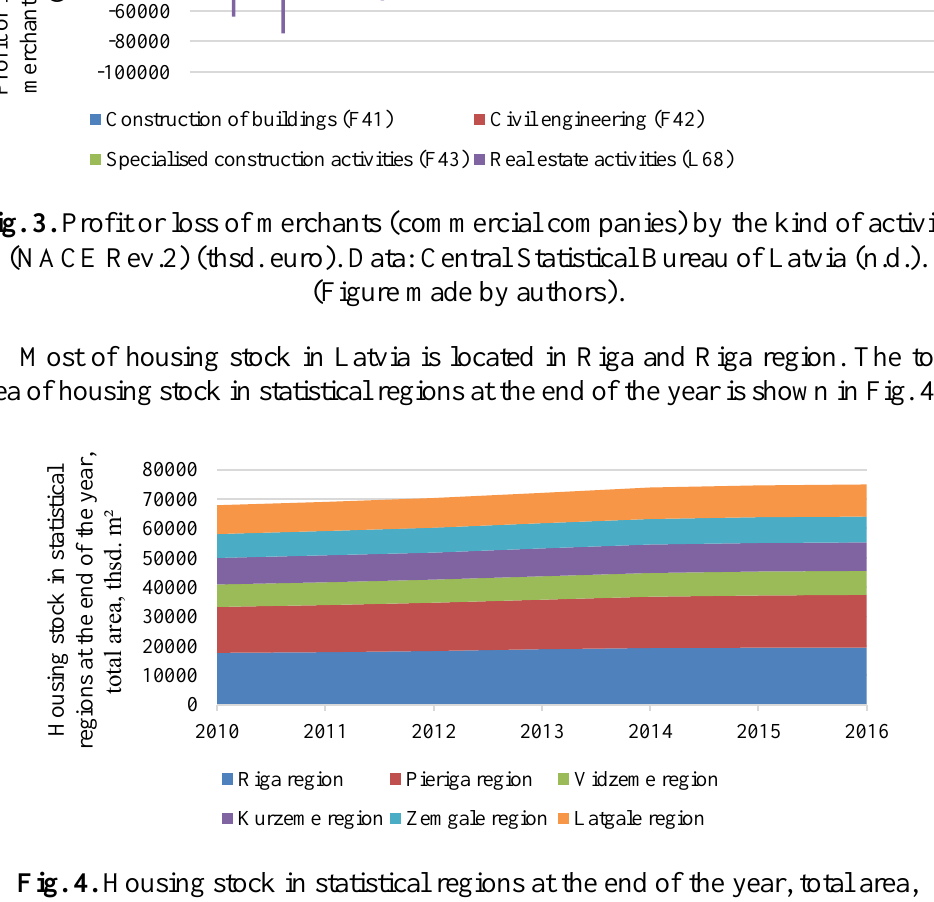
Fig. 4. Housing stock in statistical regions at the end of the year, total area, thsd. m². Data: Central Statistical Bureau of Latvia (n.d.). (Figure made by